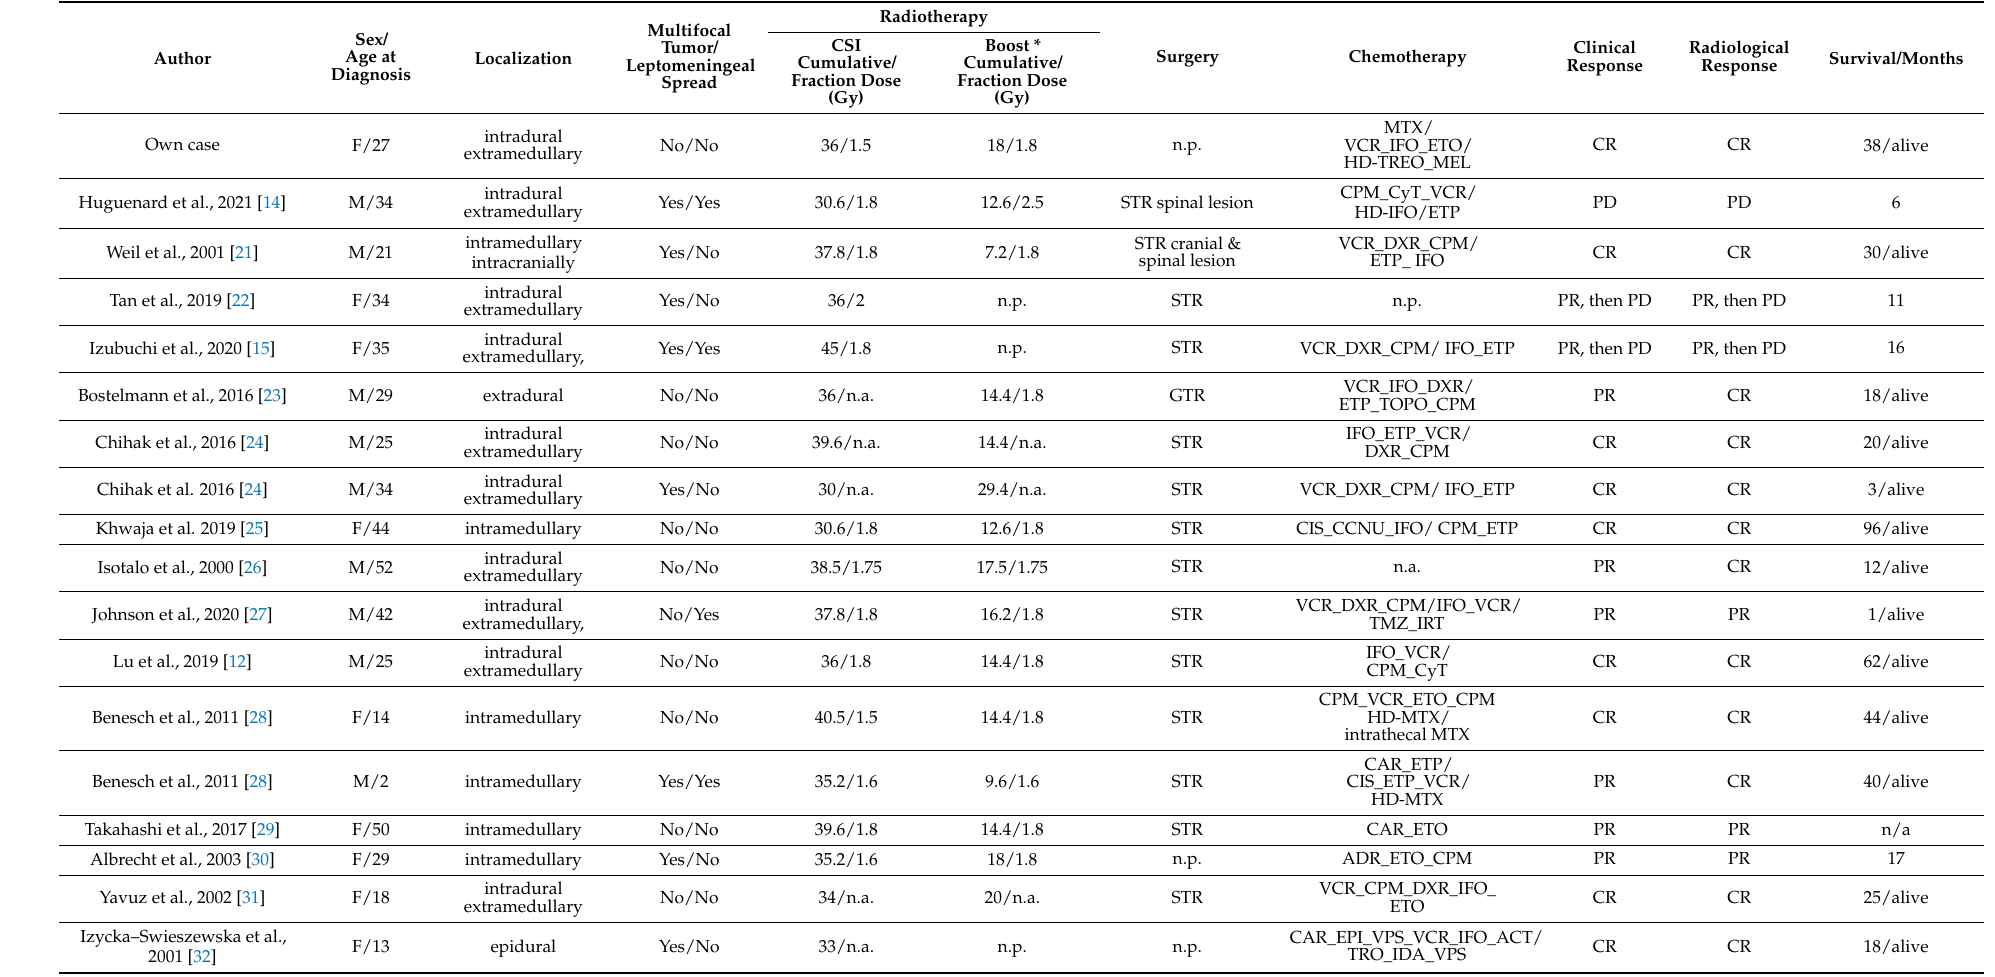
Table 1. Overview of cases from the literature of primary extraskeletal intraspinal EwS treated with craniospinal